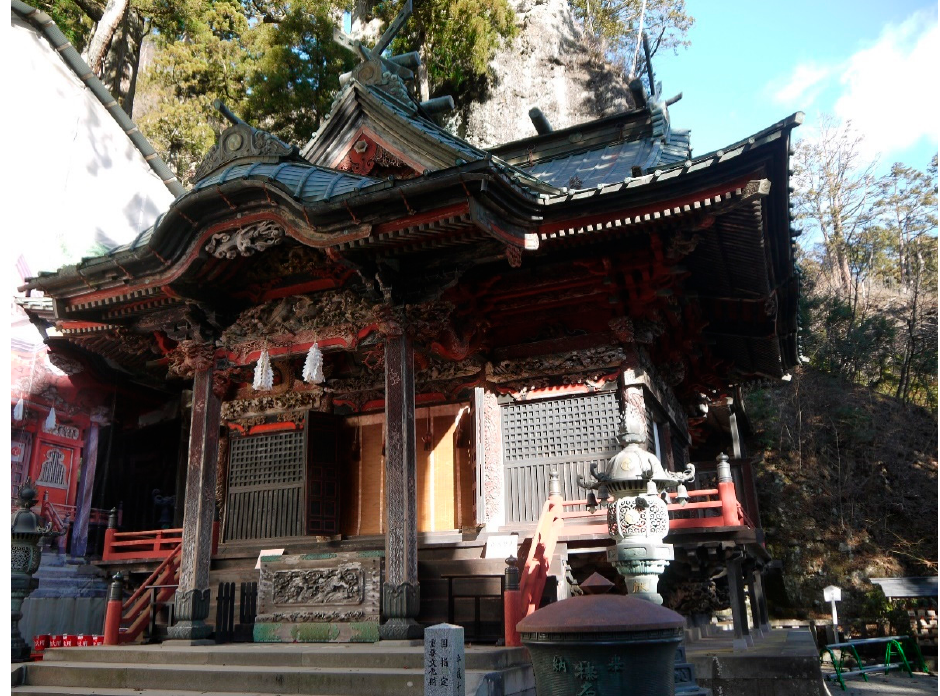
Figure 1. Honden (main building) and Misugata-iwa of Haruna Shrine. Photo by author on